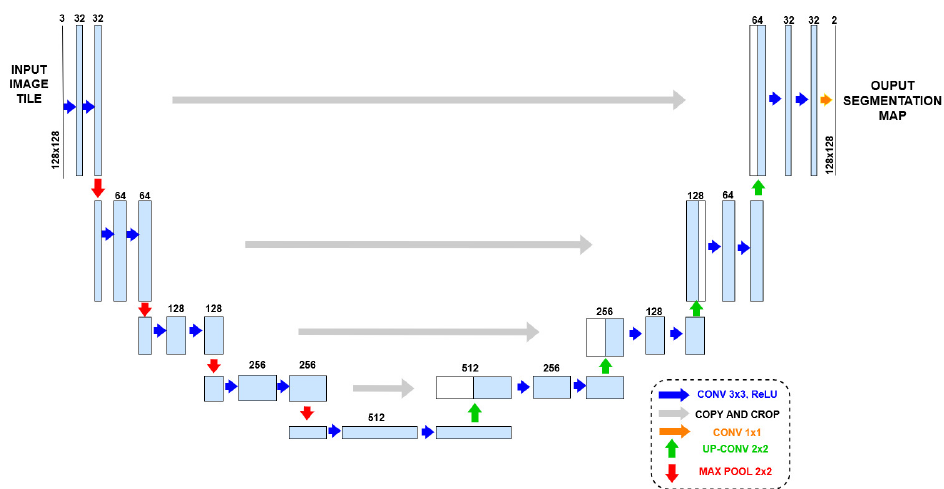
Figure 1. Model of the U-Net architecture used in this work. Each blue rectangle represents a multi- channel feature map. The number of channels is written above each box and represents the value used in the experiments. The white boxes represent the copied feature maps. The arrows denote the type of operation